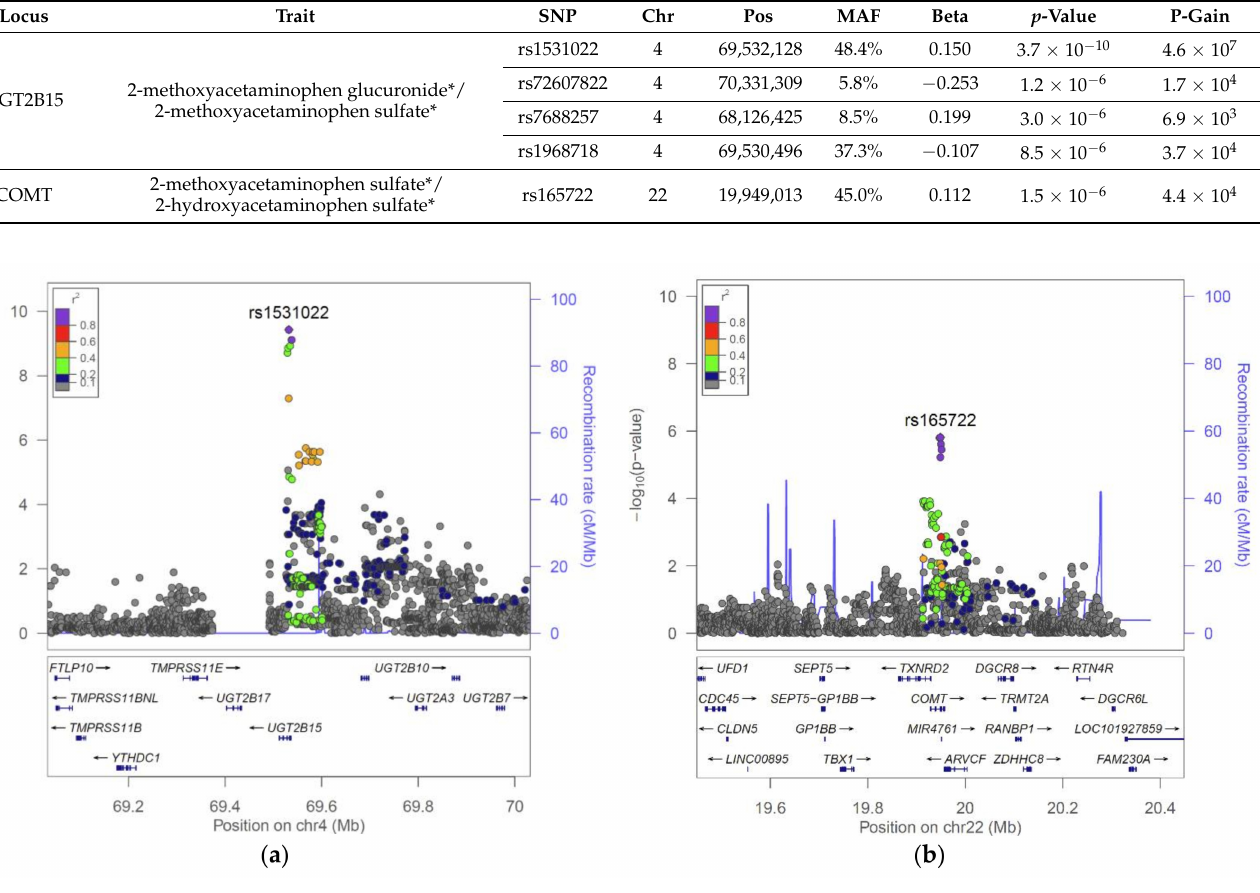
Figure 1. Regional association plots for the UGT2B15 ( a ) and the COMT ( b ) loci with the ratios 2- methoxyacetaminophen glucuronide*/2-methoxyacetaminophen sulfate* and 2-methoxyacetaminophen sulfate*/2-hydroxyacetaminophen sulfate*,